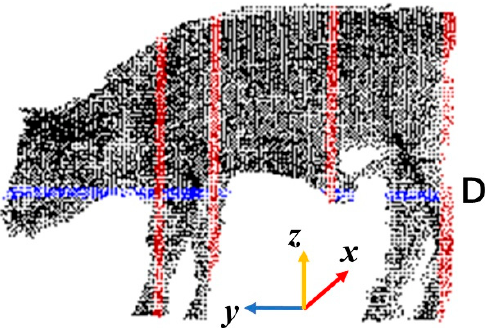
Figure 12. The location of the horizontal slice for beef cattle.